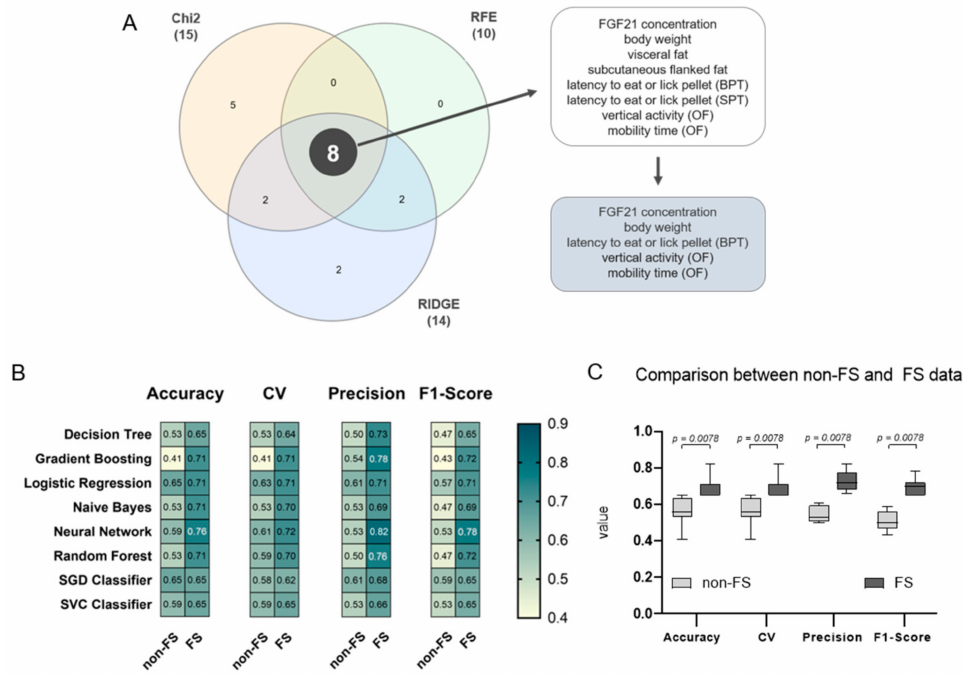
Figure 10. Feature extraction and validation of feature selected (FS) data. ( A ) To extract weighted fea- tures of the data set, three different FS algorithms were applied (Chi-Square (Chi2), Recursive feature elimination (RFE), and Ridge regularisation (RIDGE)). Generated features are represented in a Venn diagram revealing eight common features, namely Fibroblast Growth Factor (FGF) 21 concentration, body weight, subcutaneous flanked fat, visceral fat, latency to eat or lick the pellet in the BPT and SPT, vertical activity, and mobility time in the OF. These features can be further restricted in a biological context yielding five features, which are FGF21 concentration, body weight, and latency to eat or lick the pellet in the BPT, vertical activity, and mobility time in the OF. ( B ) Heatmap representation of the classification report for each ML model, namely Decision Tree, Gradient Boosting, Logistic Regression, Naive Bayes, Neural Network, Random Forest, SGD Classifier, and SVC Classifier. Dark petrol blue colour indicates a higher accuracy, mean accuracy in 6-fold cross-validation (CV), preci- sion or F1-score; yellow colour indicates the contrary. For a complete classification report with the best parameters see Table S2. ( C ) Models based on the FS data set (dark grey) scored significantly higher compared to models based on the non-FS data set (light grey) with p = 0.0078, respectively. Significance of differences was tested by Wilcoxon Signed Rank Test where theoretical medians ( tm ) were set to the mean of the corresponding non-FS data: tm of accuracy = 0.56; tm of CV = 0.56; tm of precision = 0.54; and tm of F1-score = 0.51. Data are presented as mean ± SD and statistical significance was set at p <